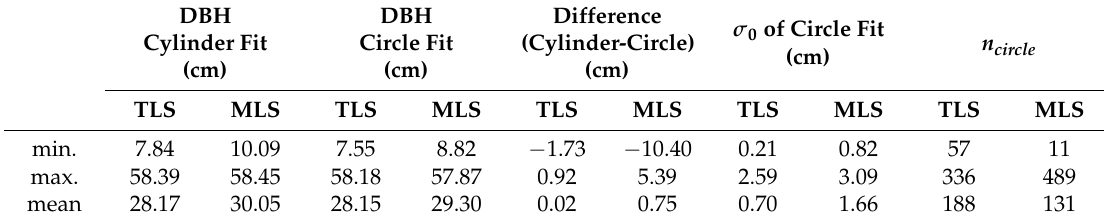
Table A1. Determined DBHs of the 24 detected TLS-trees and 21 detected MLS-trees of plot 1. The difference results from DBH cylinder –DBH circle .